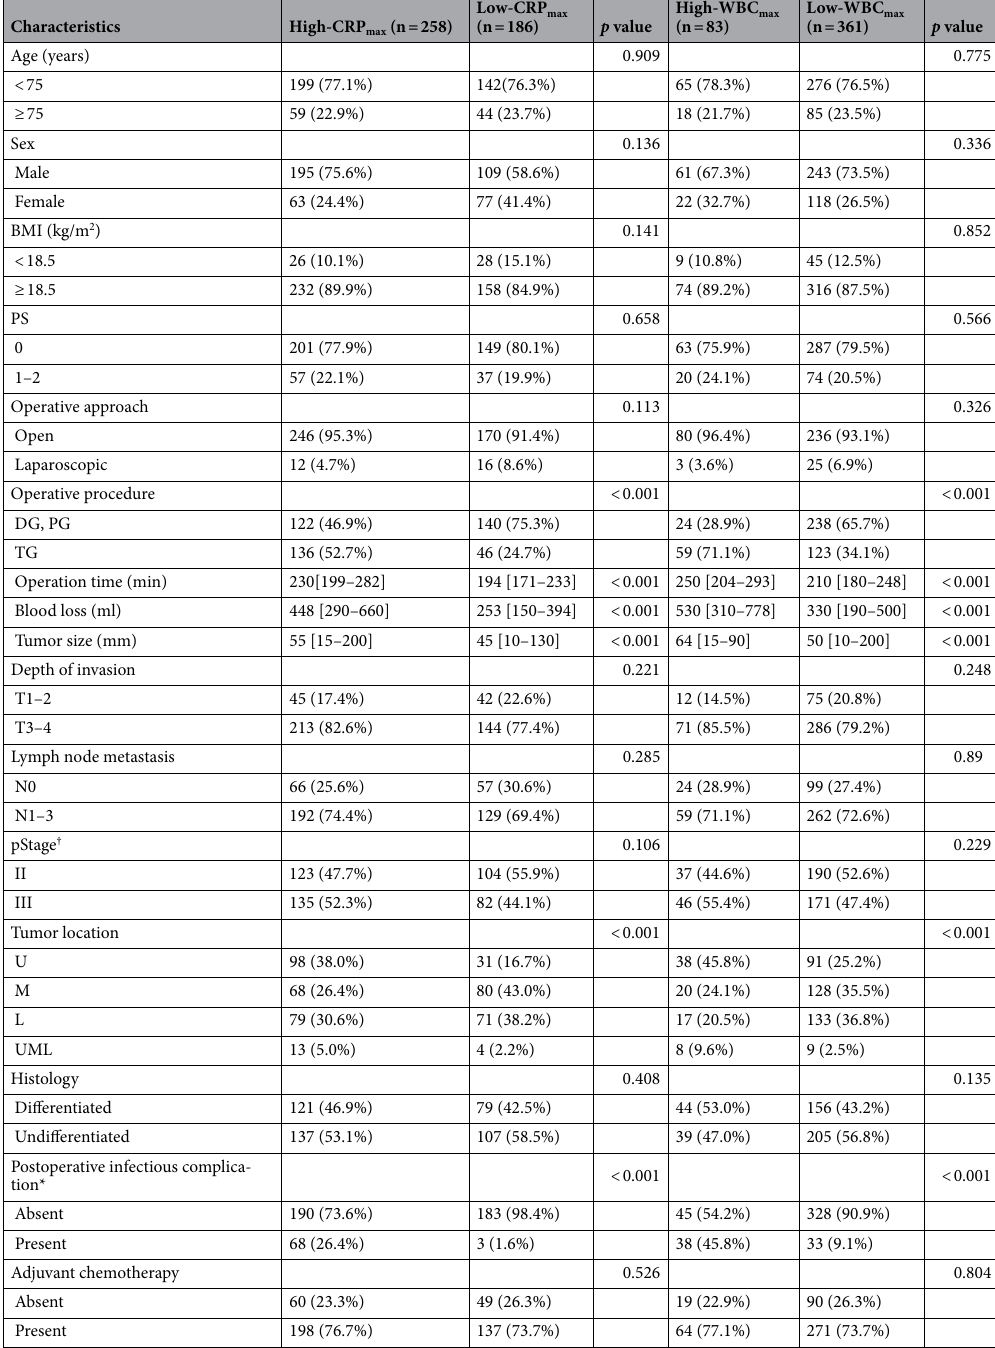
Table 1. Patient characteristics. Values in parentheses are percentages unless indicated otherwise; values are all median (i.q.r.) BMI body mass index, PS performance status, DG distal gastrectomy, PG proximal gastrectomy, TG total gastrectomy, U upper, M middle, L lower. † According to the 7th edition of the International Union Against Cancer. *Intra-abdominal abscess, anastomotic leakage, pancreatic fistula, pneumonia, surgical site infection, acute cholecystitis, and enteritis Grade ≥ 2 based on the Clavien-Dindo